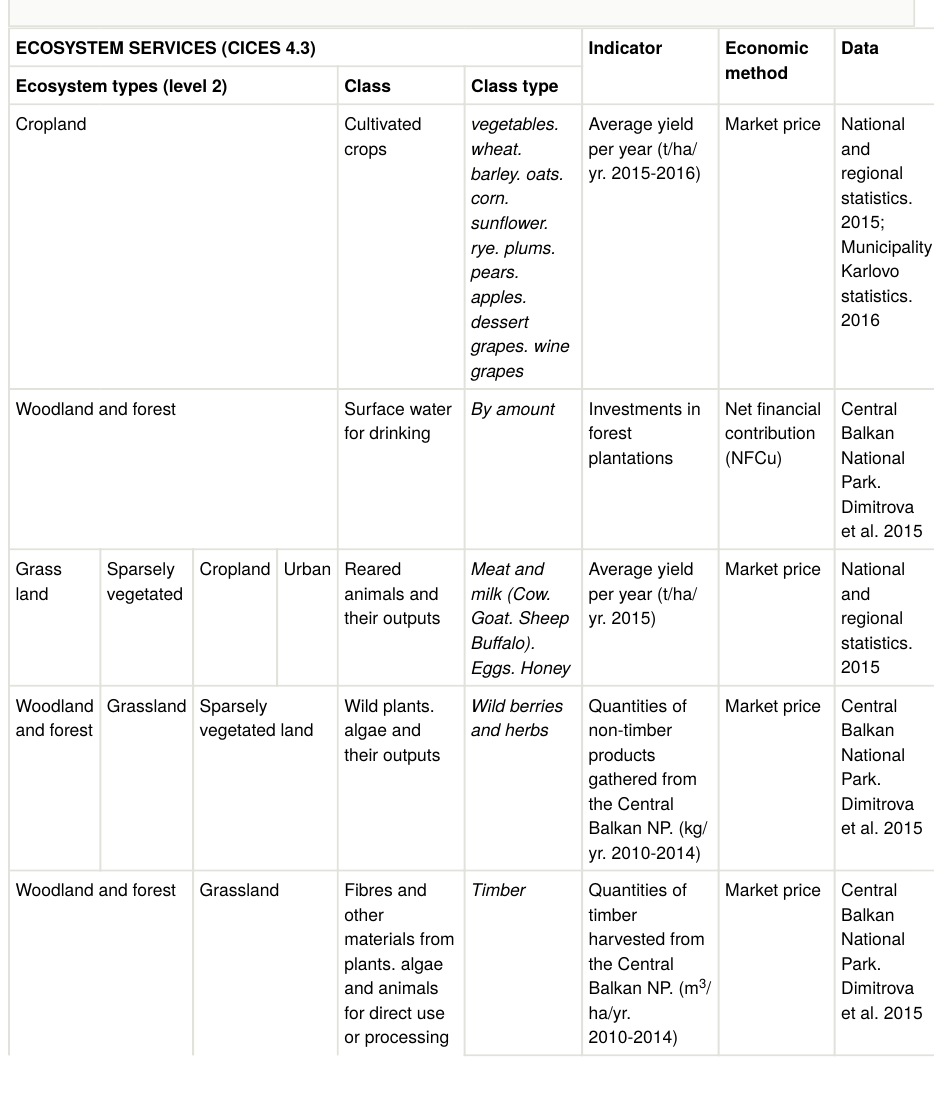
Methods and Indicators for Representative Ecosystem Services in the Karlovo